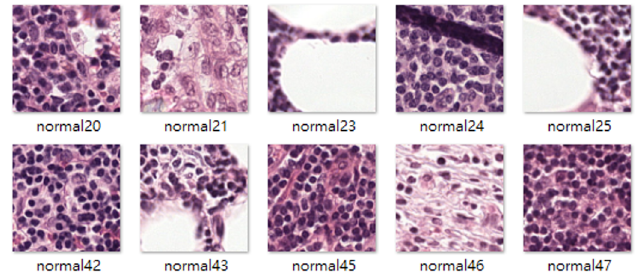
Figure 7. Samples of type B stain images.